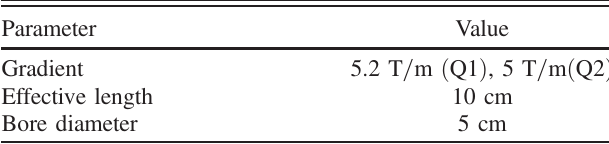
TABLE V. Magnetic quadrupoles ’ nominal